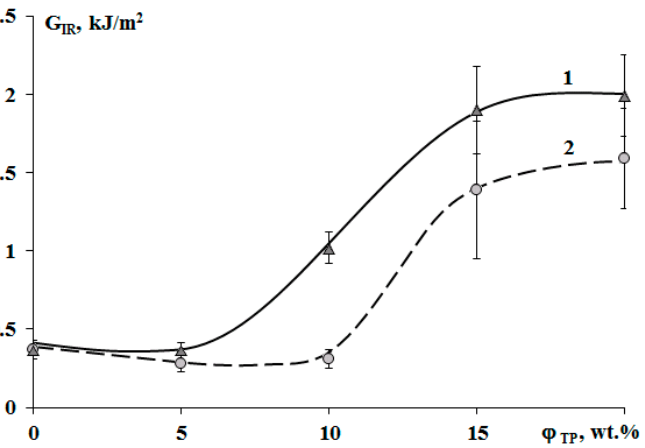
Figure 13. Concentration dependences of crack resistance (G IR ) of cured epoxy–TP compositions modified with PSU (1) and PES (2). modified with PSU (1) and PES